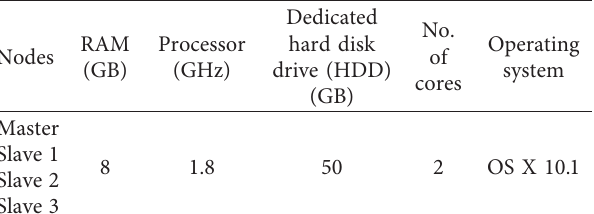
Table 4: Configuration of